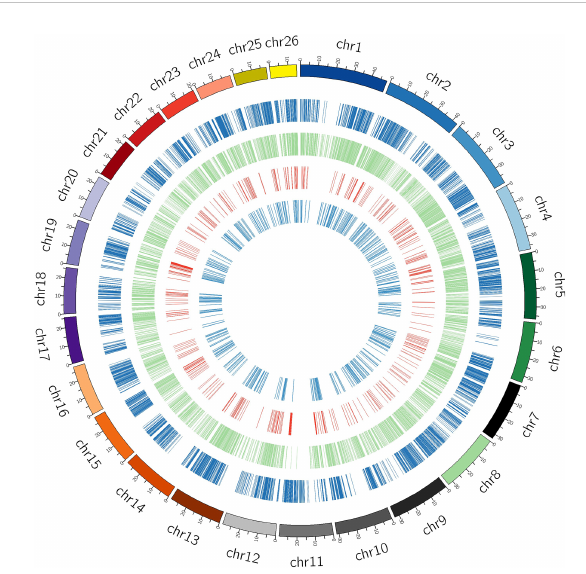
FIGURE 5 (A) RNAFold structure of lncRNA TCONS_00294108 showing the precursor (red) and mature (yellow) sequence of miRNA vvi-miR156i. (B) Structure of lncRNA TCONS_00240461 harboring the target sites of two miRNAs zma-miR159c and